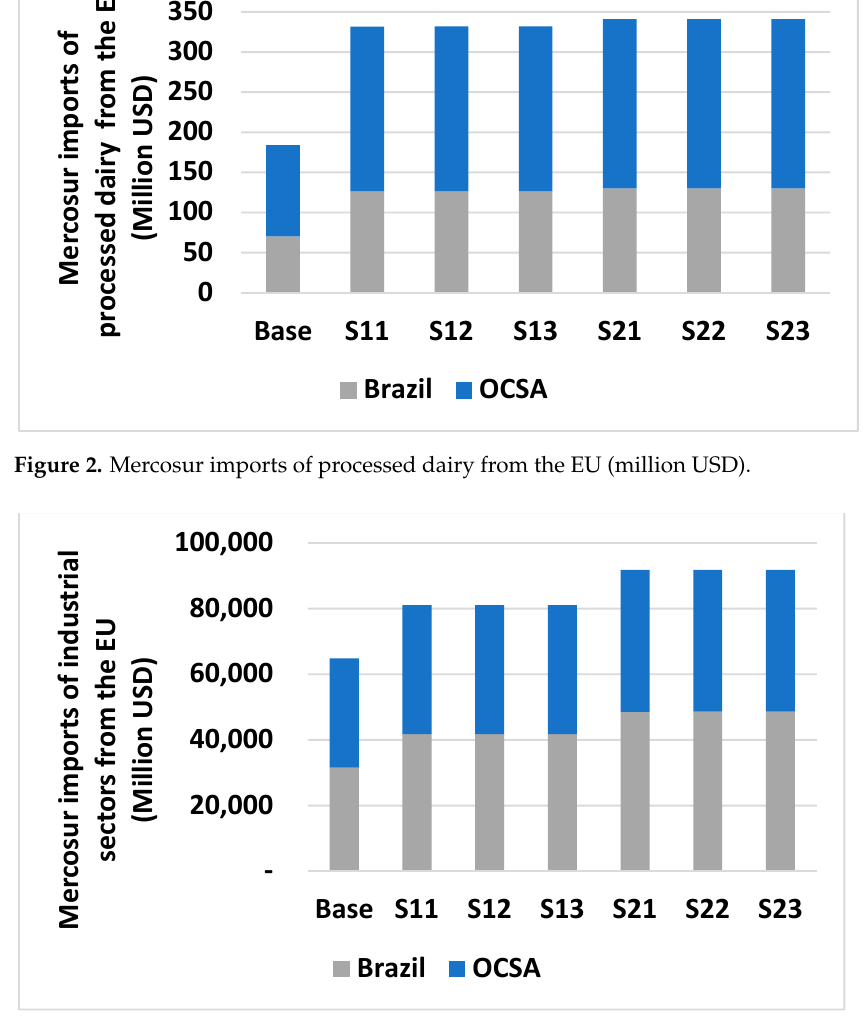
Figure 3. Mercosur imports of industrial sectors from the EU (million